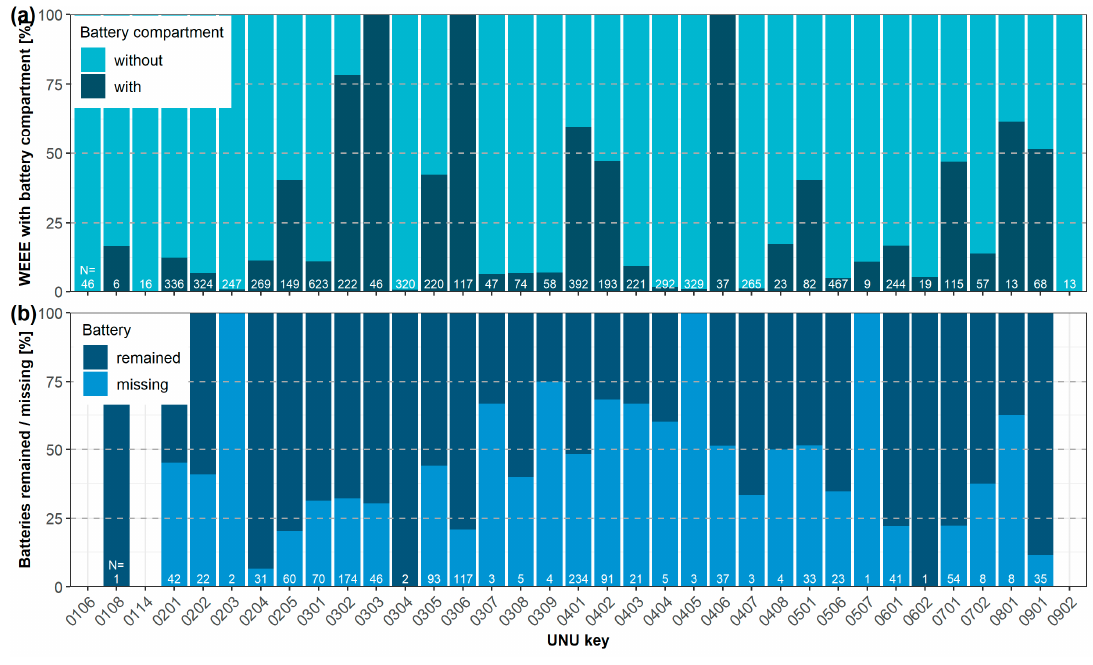
Figure 2. The proportion of WEEE devices (UNUkeys) with and without battery compartment ( a ) and the proportion of WEEE with a battery compartment in which batteries remained or were missing ( b ). The total number of appliances (N) is shown in white at the bottom. Figure data available in Supplementary Materials Table S3.